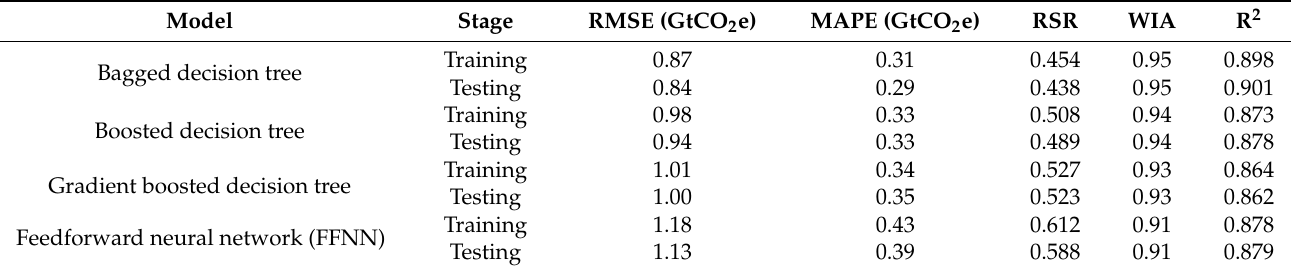
Table 2. Statistical performance measures for employed decision tree